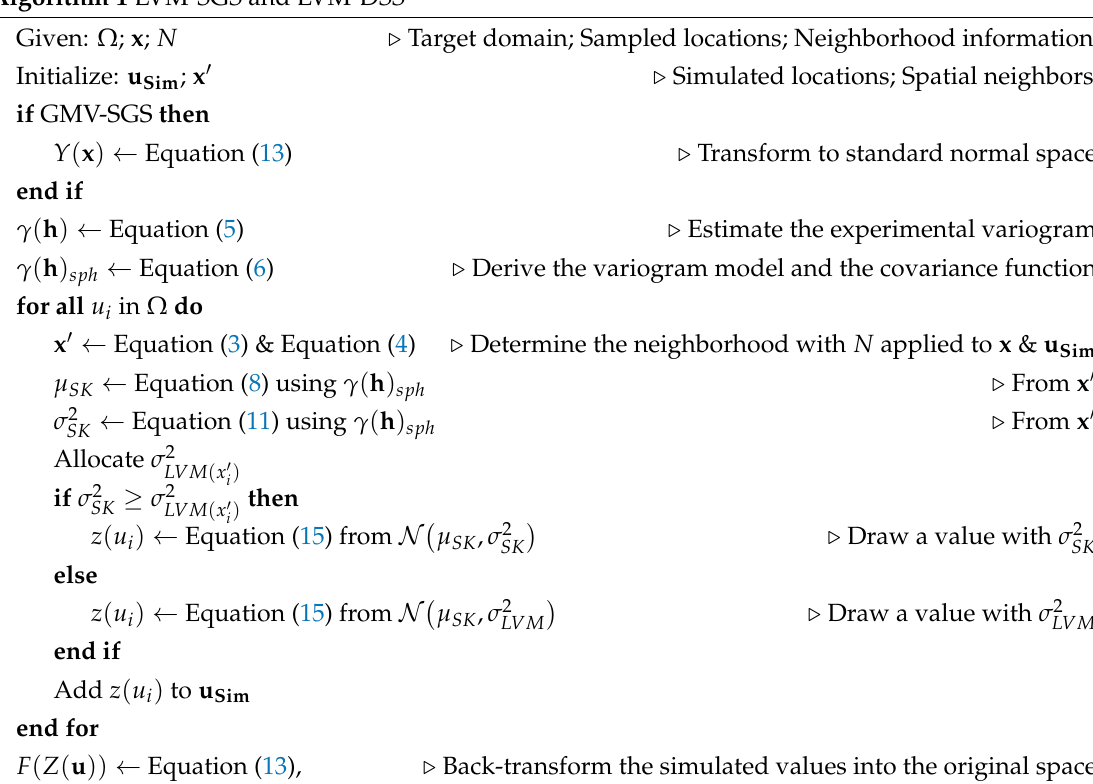
Algorithm 1 LVM-SGS and